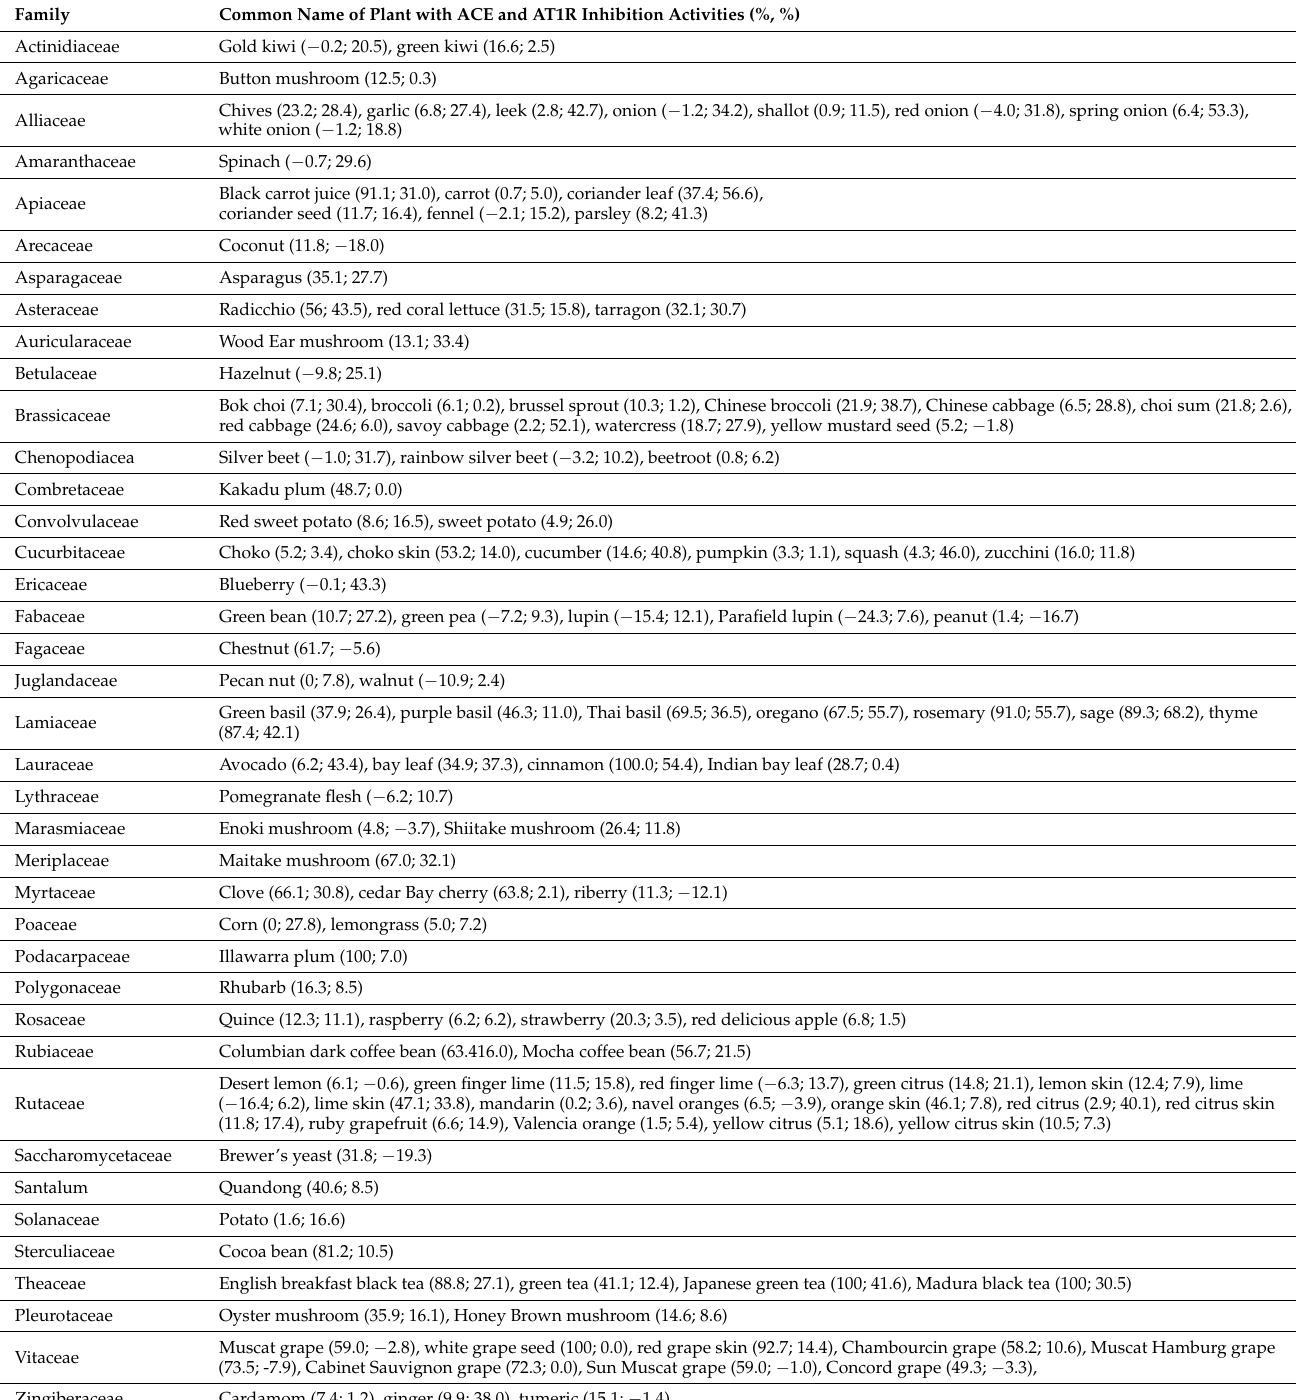
Table 3. Studies based on food for human consumption ACEi activity () and inhibition of AII to AT1R binding